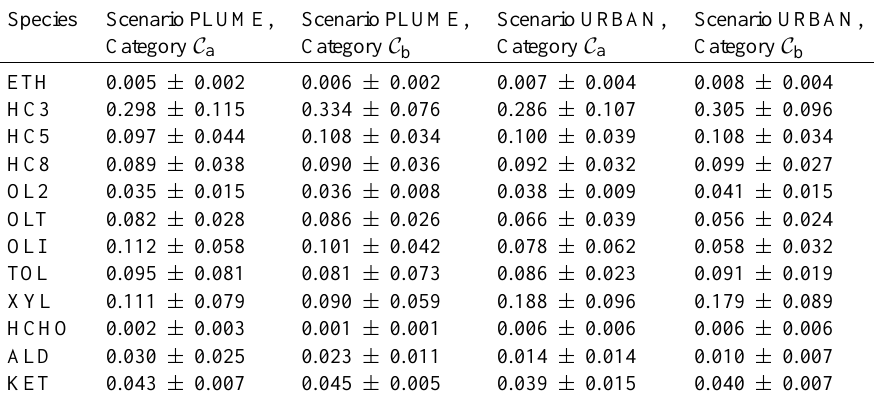
Table 9. Mean impact and standard deviation of VOCs for categories C a and C b . Considered are optimal projected relative singular vectors with respect to emissions uncertainties and final projection on O 3 and